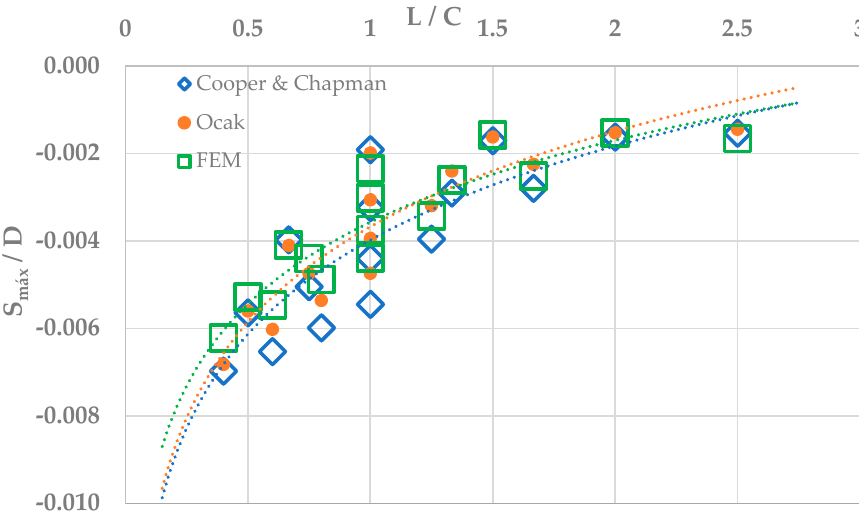
Figure 9. Maximum settlement for different methodologies.